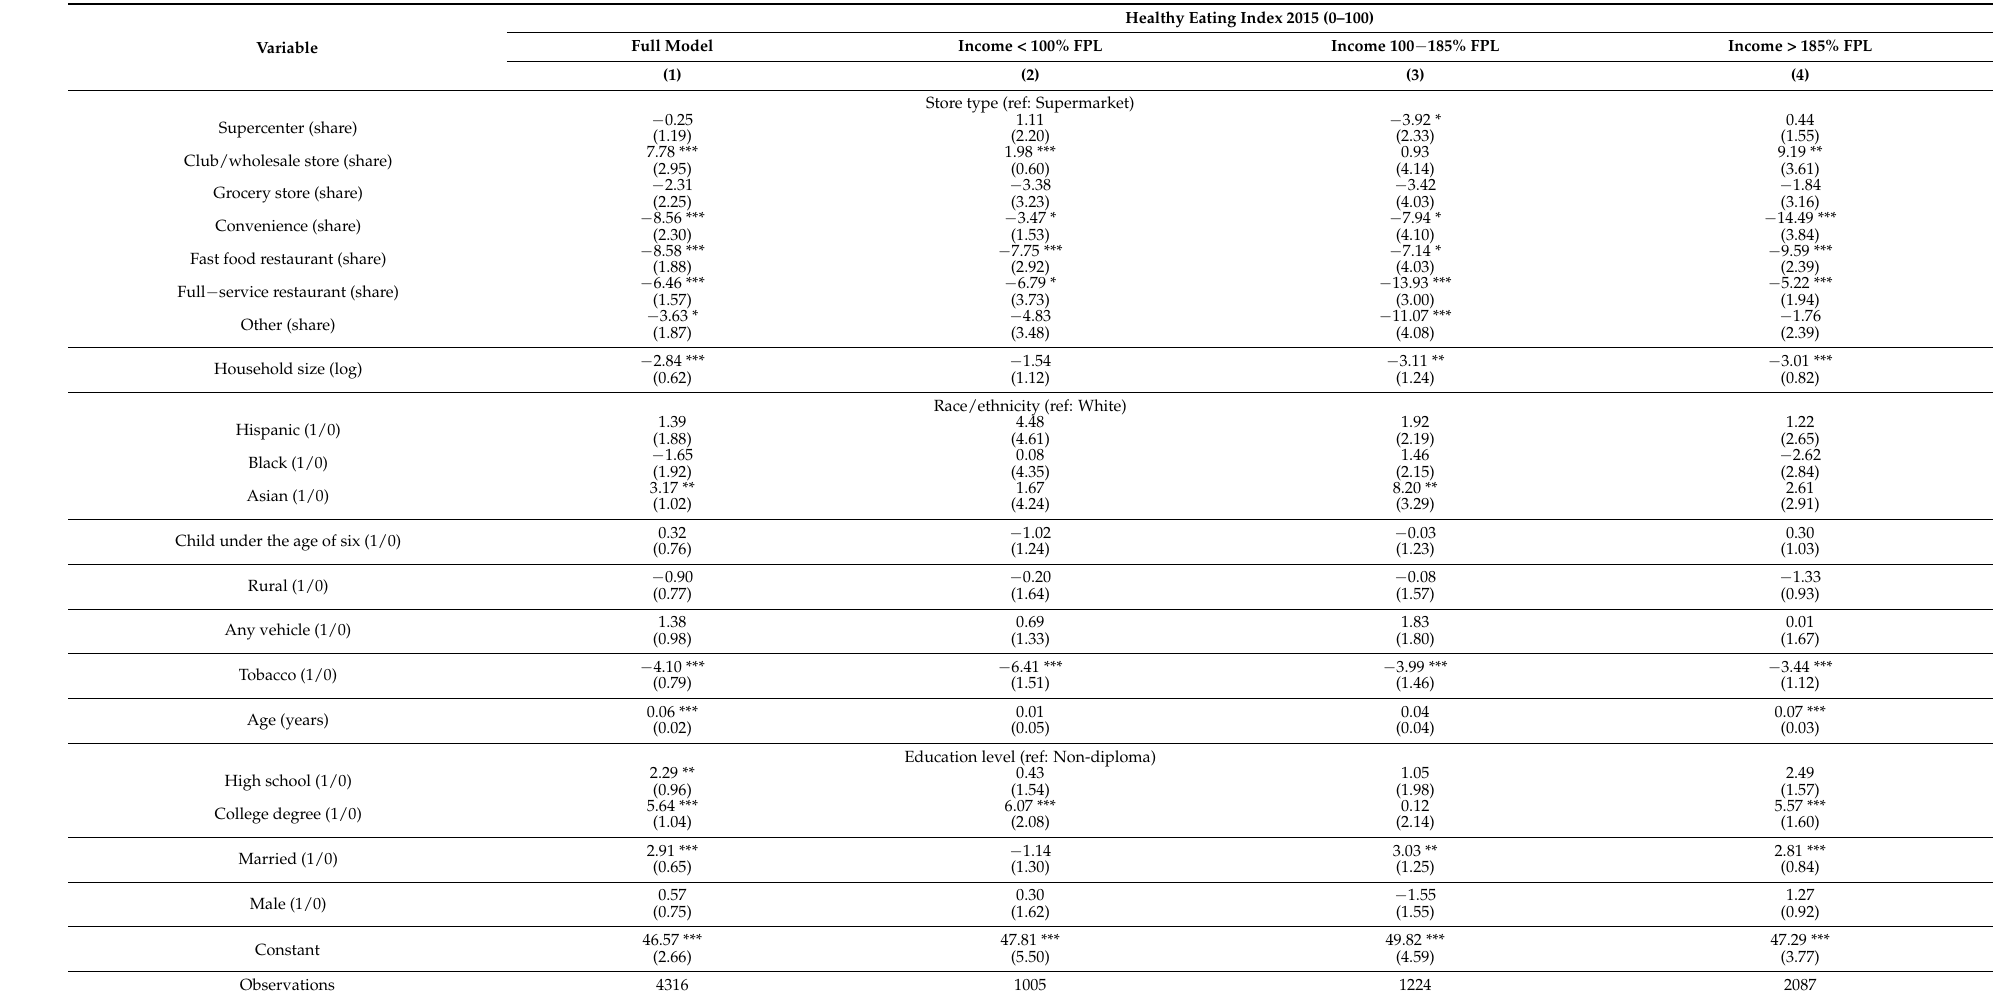
Table 3. Association between healthy eating index 2015 and food outlet types by